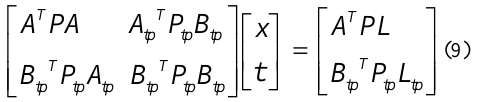
were measured by the GPS over the whole country. Fig. 2 (a) and (b) show the spatial distribution of the satellite images and check points.